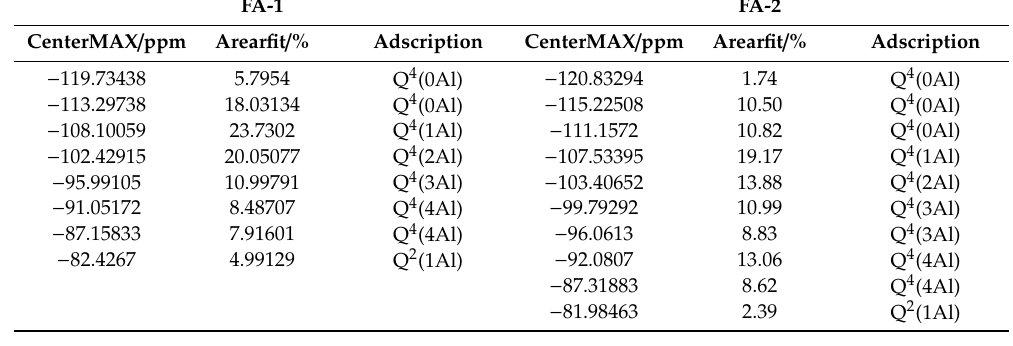
Figure 7. The 29 Si magic angle spinning nuclear magnetic resonance (MAS–NMR) spectra for FA-1 and FA-2. Table 4. The deconvolution results of the 29 Si MAS–NMR spectra for FA-1 and FA-2.